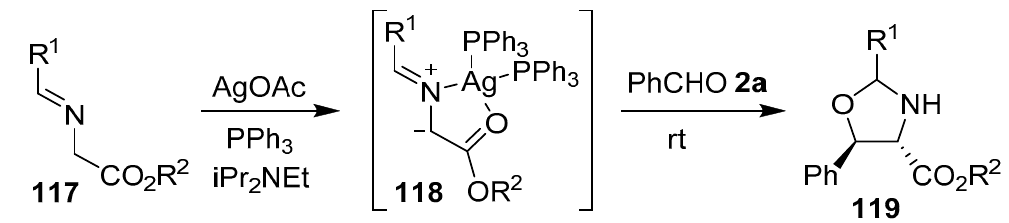
Scheme 29. Cycloaddition of N -metalated azomethine ylides 118 , generated from α -iminoesters 117 , to benzaldehyde ( 2a Table 15. Cycloaddition of N -metalated azomethine ylide 118 to benzaldehyde ( 2a ) (Scheme 29) 1 .